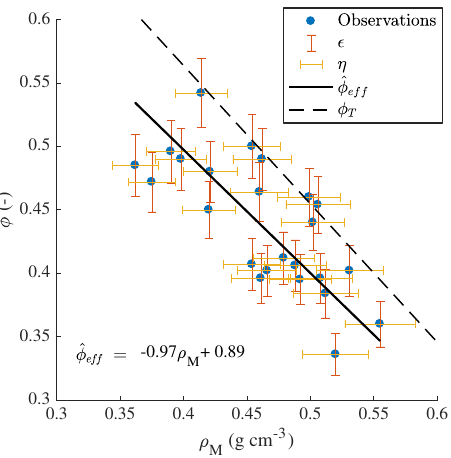
Figure 6. Linear relationship ( ˆ φ eff solid line) between measured ice density ( ρ M ) and effective porosity ( φ eff ) and assumed ± 10% measurement error (whiskers). Dashed line is theoretical upper limit where effective porosity equals total porosity (i.e. φ T = ρ M /ρ T )